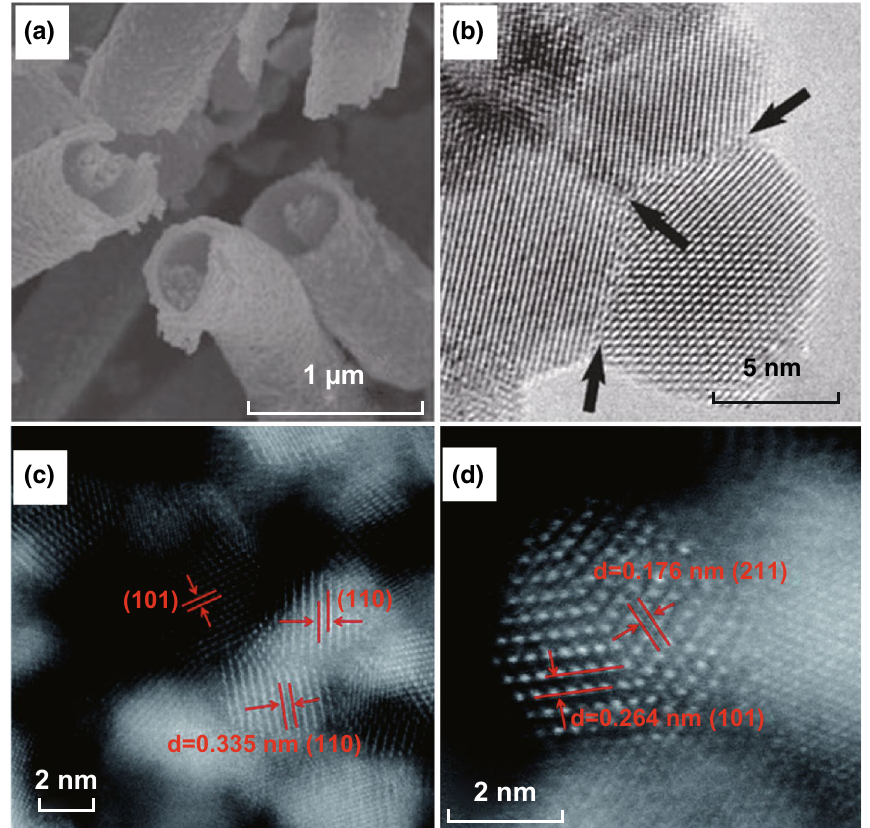
Fig. 7 a SEM image of the WIT SnO 2 nanofibers. b High‑resolution TEM (HRTEM) image of the WIT SnO 2 nanofibers with a high density of GBs. Reprinted with permission from Ref. [74]. c, d HRTEM images of SnO 2 nanoparticles. Reprinted with permission from Ref.